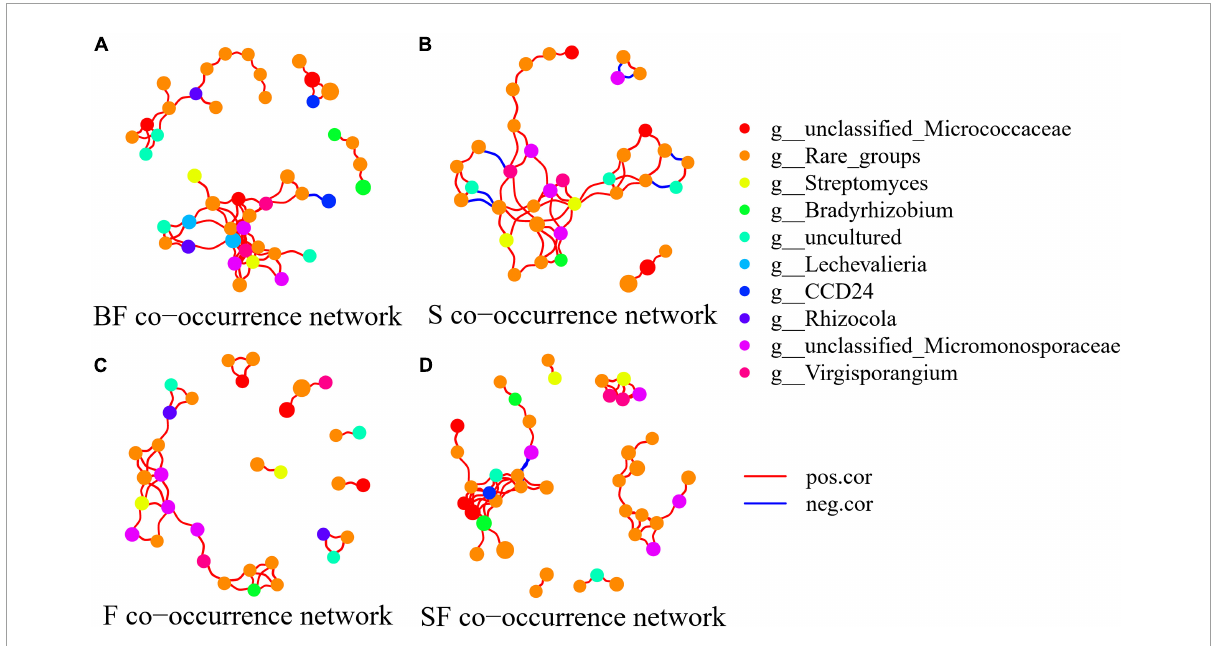
FIGURE8 Network analysis showed the co-occurrence patterns of soil bacterial taxa at maturity stage in different treatments. (A) BF, (B) S, (C) F, and (D) SF. The size of each node is proportional to the relative abundance. The blue line represents a significant negative relationship ( p < 0.05) between nodes, and the red line represents a significant positive relationship ( p < 0.05) between nodes.